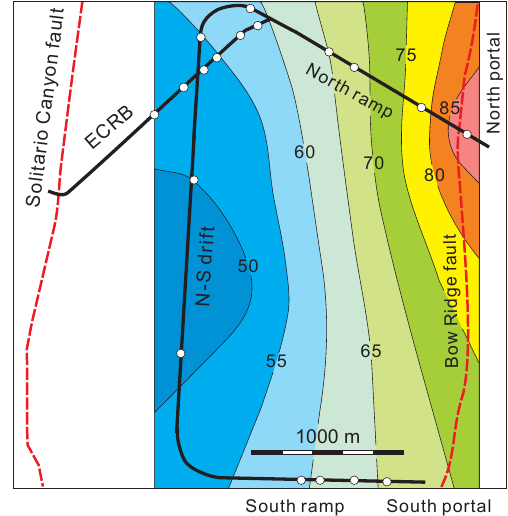
Figure 5. Reconstructed field of maximum paleotemperatures ( ◦ C) in the repository block, at the ESF level (from Dublyansky and Polyansky, 2007; based on the data reported in Dublyansky et al., 2001; Wilson et al., 2003; Whelan et al., 2003, 2008).